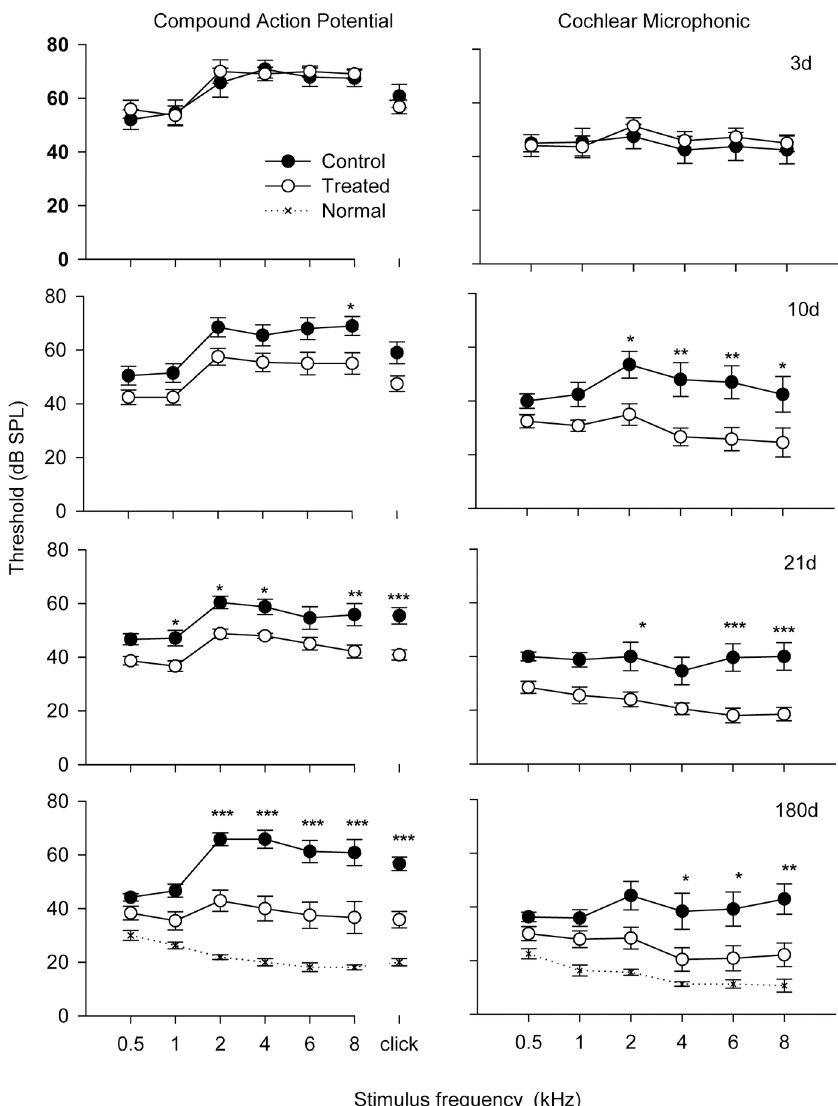
Fig 4. Compound action potential (CAP) and cochlear microphonic (CM) threshold change as a function of test frequency over different time groups plotted in the same format as Fig 1. Each samplinggroup containedreadingsfrom six animals. The results show a decreasein both CAP and CM thresholds for HPN-07 treated animalsrelative to control animalsbeginningat 10 days after blast exposure. Significant differenceswere detected by two-way ANOVA analysis. The symbols of * ; ** ; *** indicate significancelevels of p < 0.05, 0.01 and 0.001, respectively.